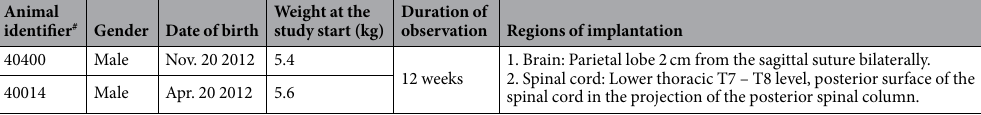
Table 1. Details and implantation locations in experimental